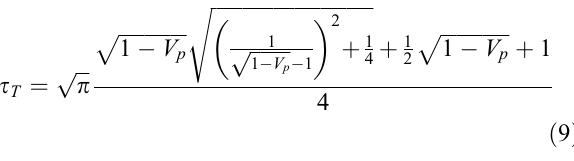
ffiffiffiffiffiffiffiffiffiffiffiffiffiffi 1 p (cid:3) V p